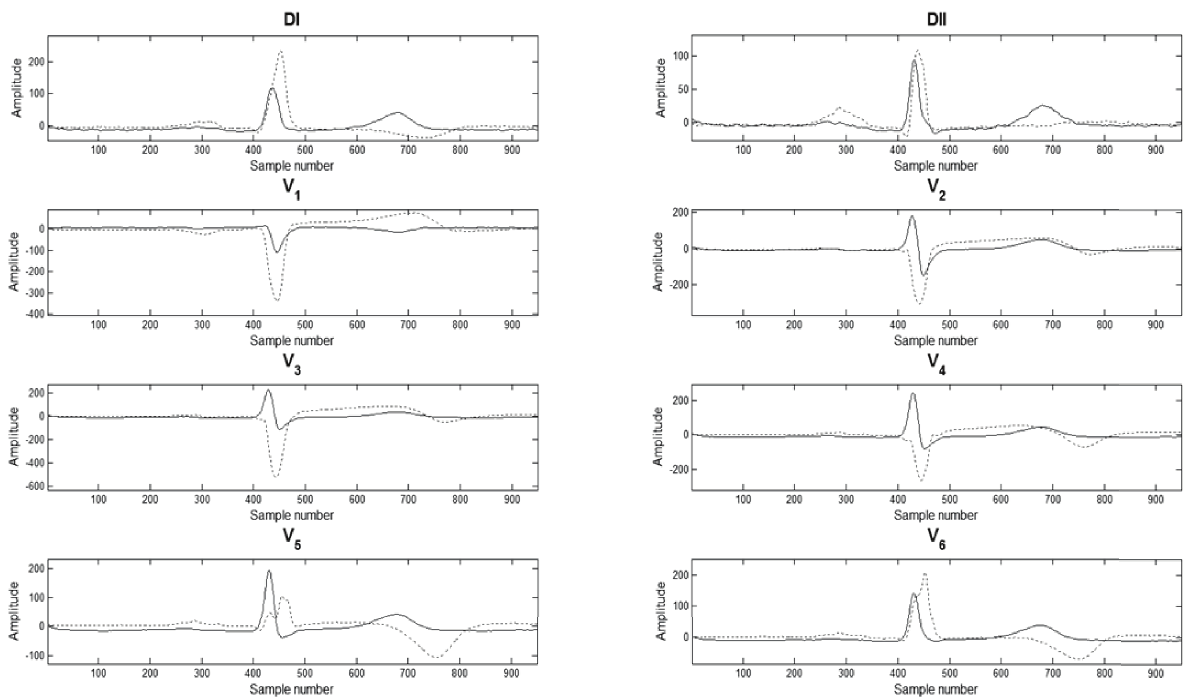
Fig. 3. Healthy patient (solid line) vs. patient with extensive anterior ischemia (dotted line) [Gem-Med ECG